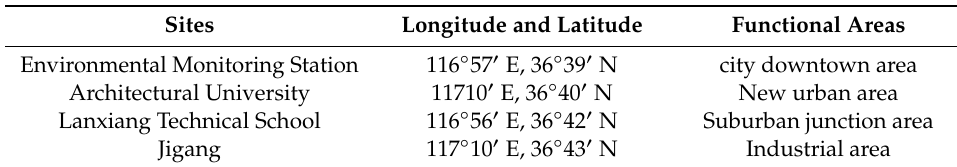
Table 1. Sampling site statistics in Jinan.